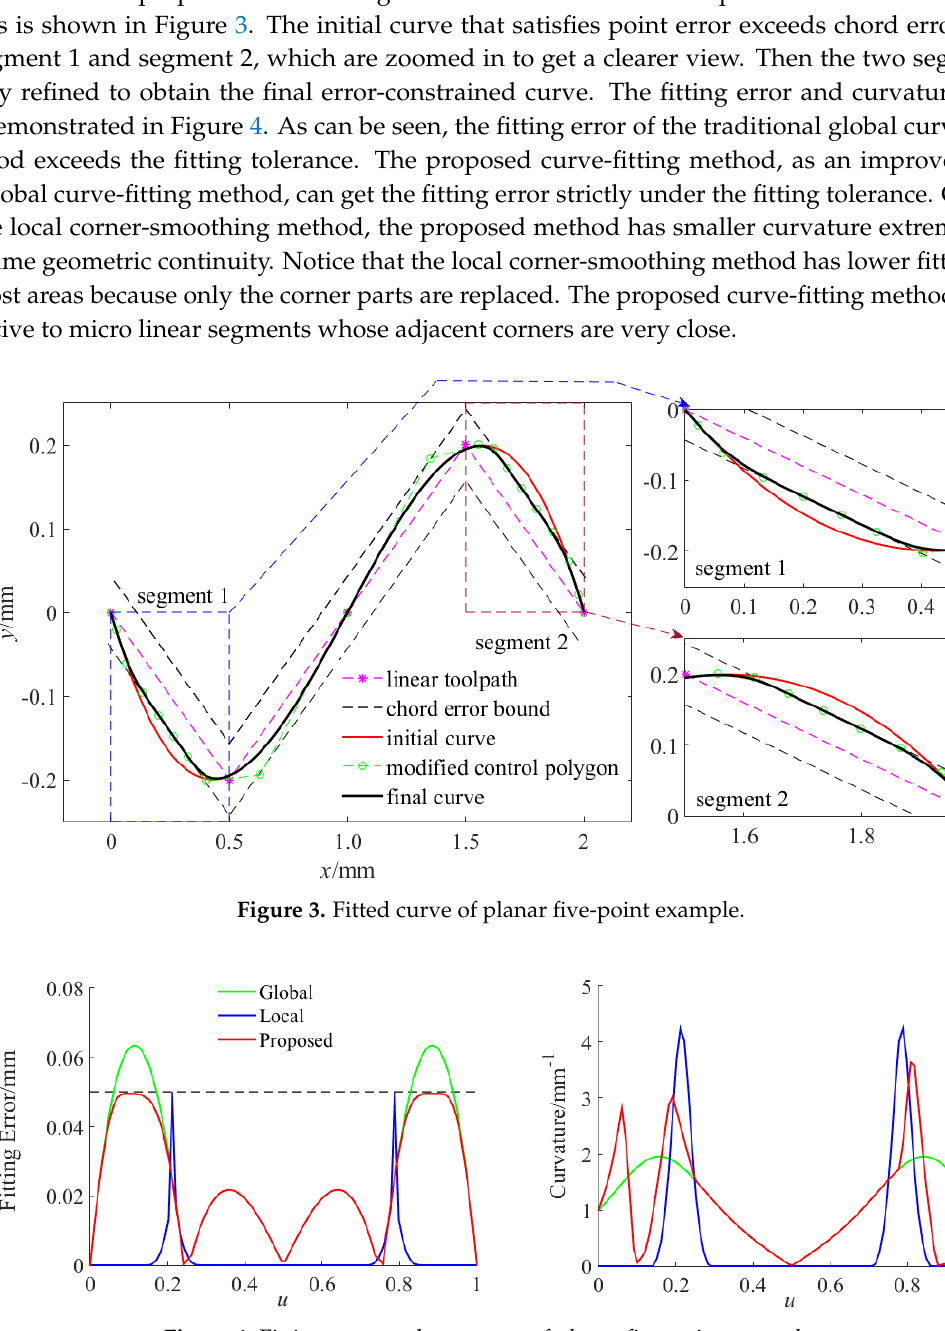
Figure 4. Fitting error and curvature of planar five-point